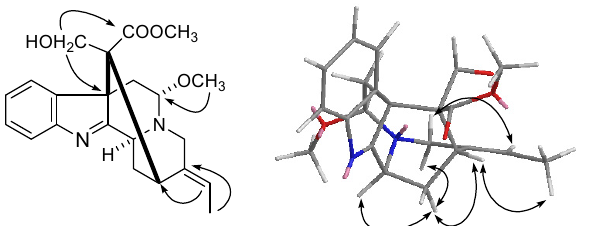
Figure 5. Key HMBC ( ) and NOESY ( ) correlations of of compound 7 .